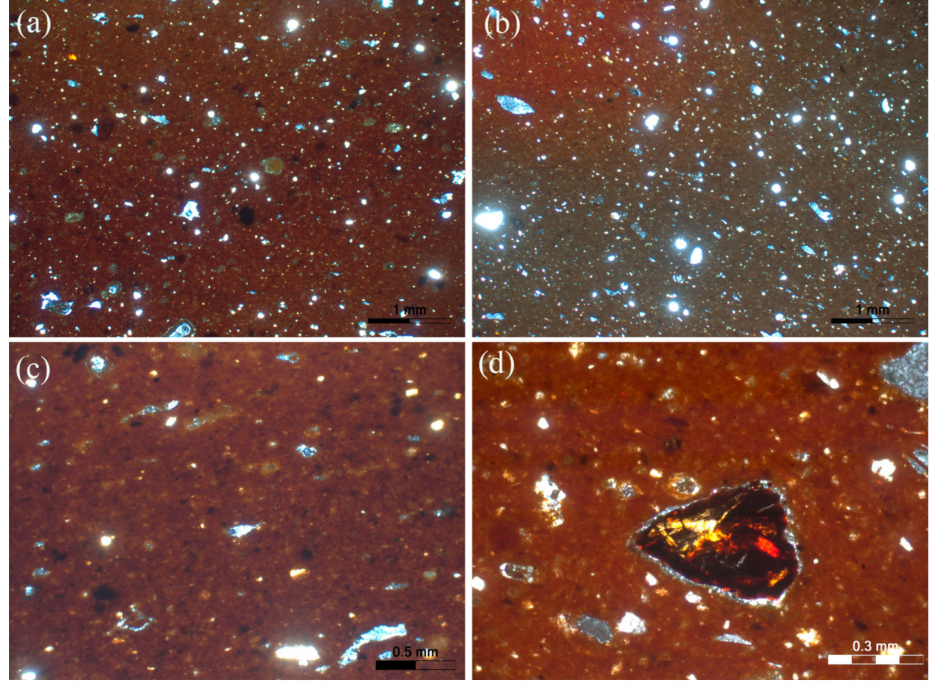
Figure 3. Representative photomicrographs of group 1: ( a ) sample K21; ( b ) sample K22; ( c ) sample K24 and ( d ) K59. All photomicrographs are taken under crossed Nicols